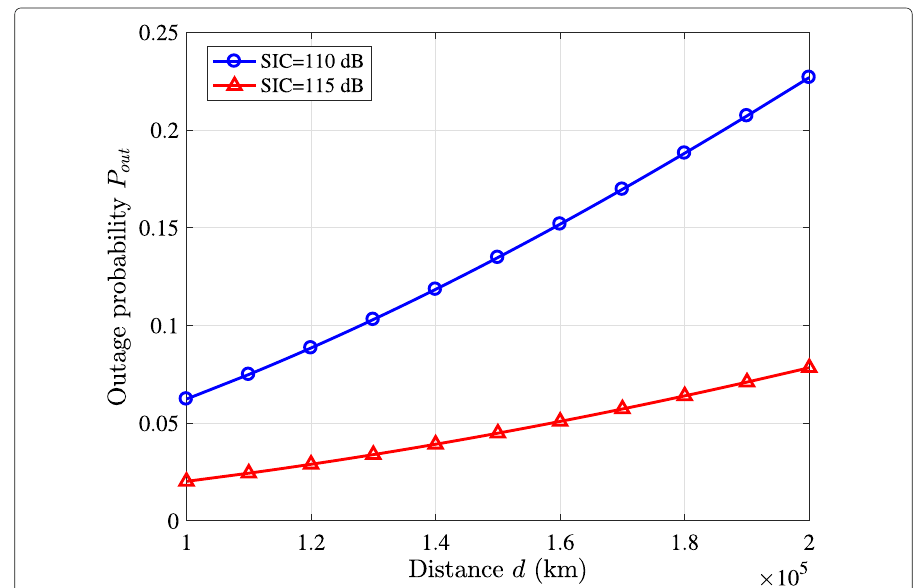
Fig. 6 Outage probability of FDQ-LoRa, in the space-air-ground scenario